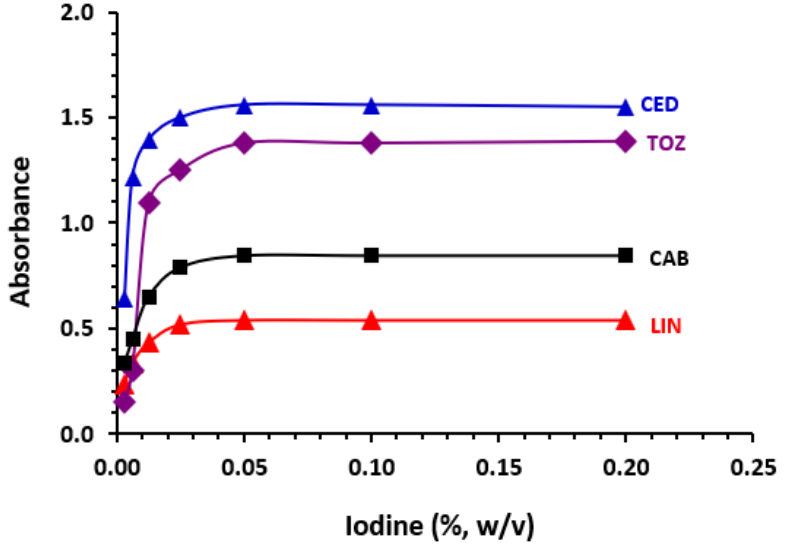
Figure 6. Plot of absorbance versus molar ratio of [Iodine]/[Drug] obtained from reaction mixtures containing a fixed concentration of drug and varying concentrations of iodine. The mole ratio corresponds to the point of intersection of the tangents of the straight-line portions of the plots. Results are given for CER and AFA as representative examples for the molar ratios of 1:1 and 1:2, respectively.